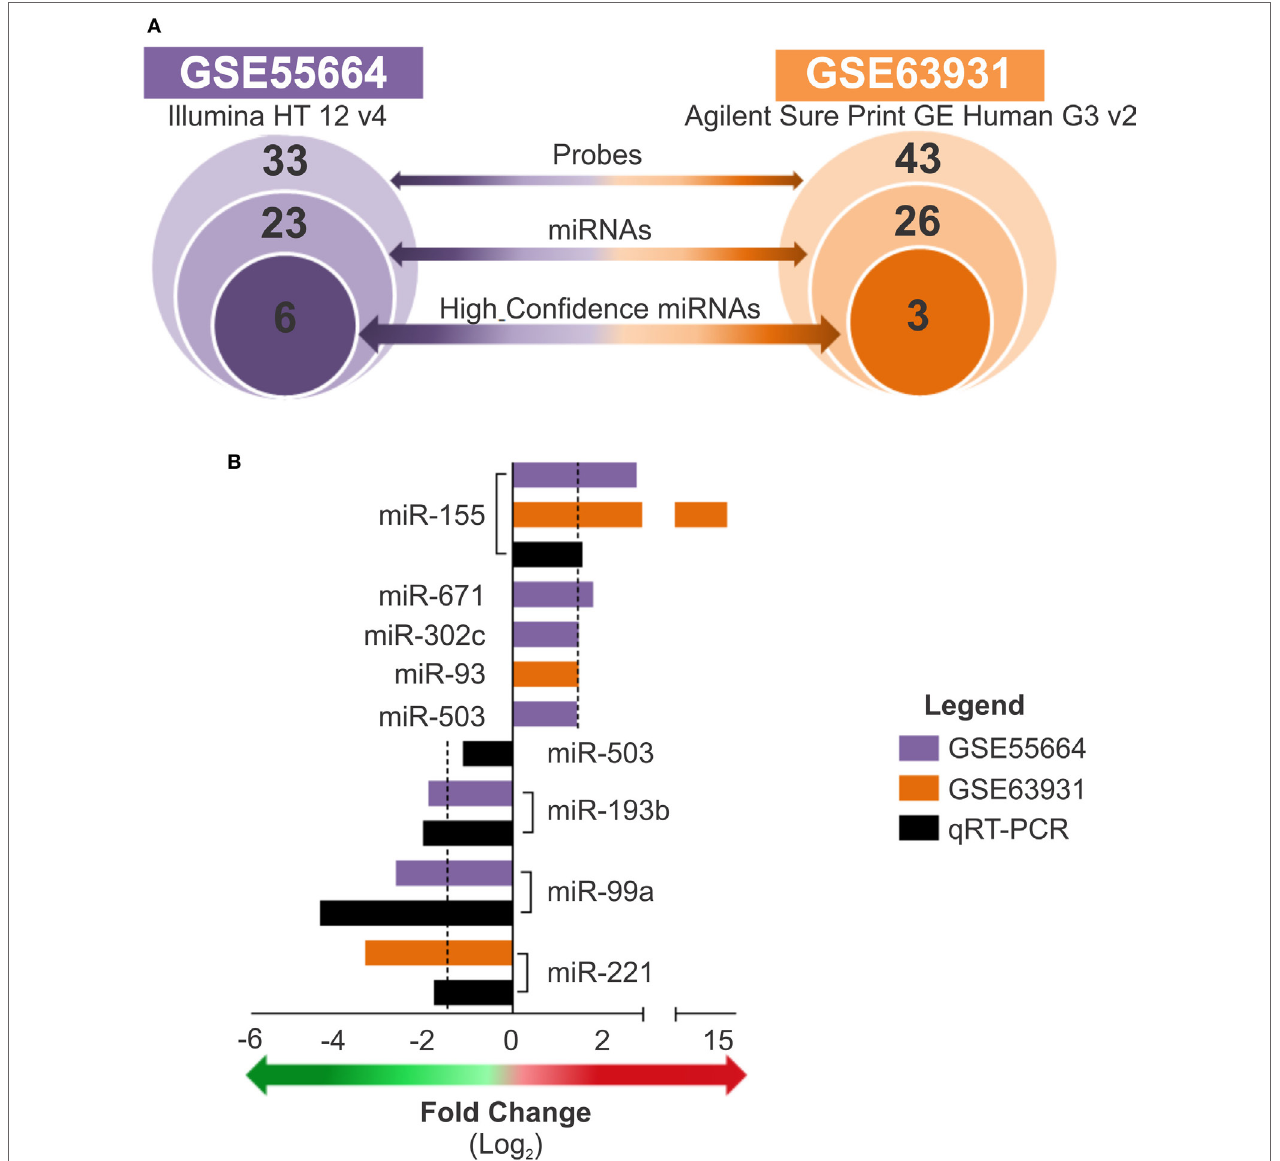
FigUre 2 | Expression of high confidence microRNAs is modulated in cutaneous lesions caused by Leishmania braziliensis . (a) The total number of probes, sequences, or high confidence microRNAs is presented for each data set, GSE55664 (purple) and GSE63931 (orange), from the outer to the inner circles, respectively ( p < 0.05). (B) Bars graph shows the fold changes of high confidence microRNAs that differentially expressed from both datasets, GSE55664 (purple bars) and GSE63931 (orange bars), as well as real-time quantitative PCR to measure the relative expression of high confidence microRNAs in new samples from active lesions of patients with localized cutaneous leishmaniasis compared with healthy control skin for validation of the identified microRNAs in another cohort (black bars). The arrows indicate upregulated (red) or downregulated (green) expression (fold change ≥